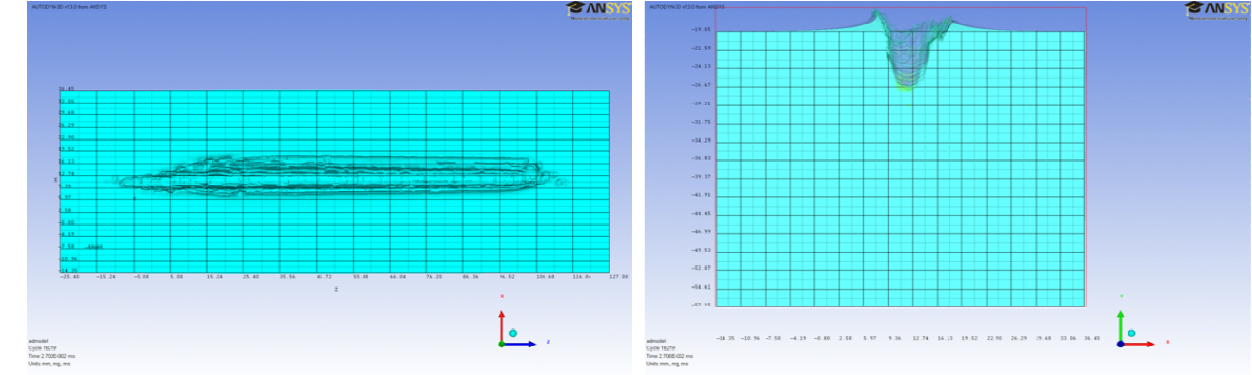
Figure 12. The penetration profile can be seen on the top of the target and in a cross section of the target at the optimum standoff distance (1.905 cm) after 15 µs (left and right pictures respectively).